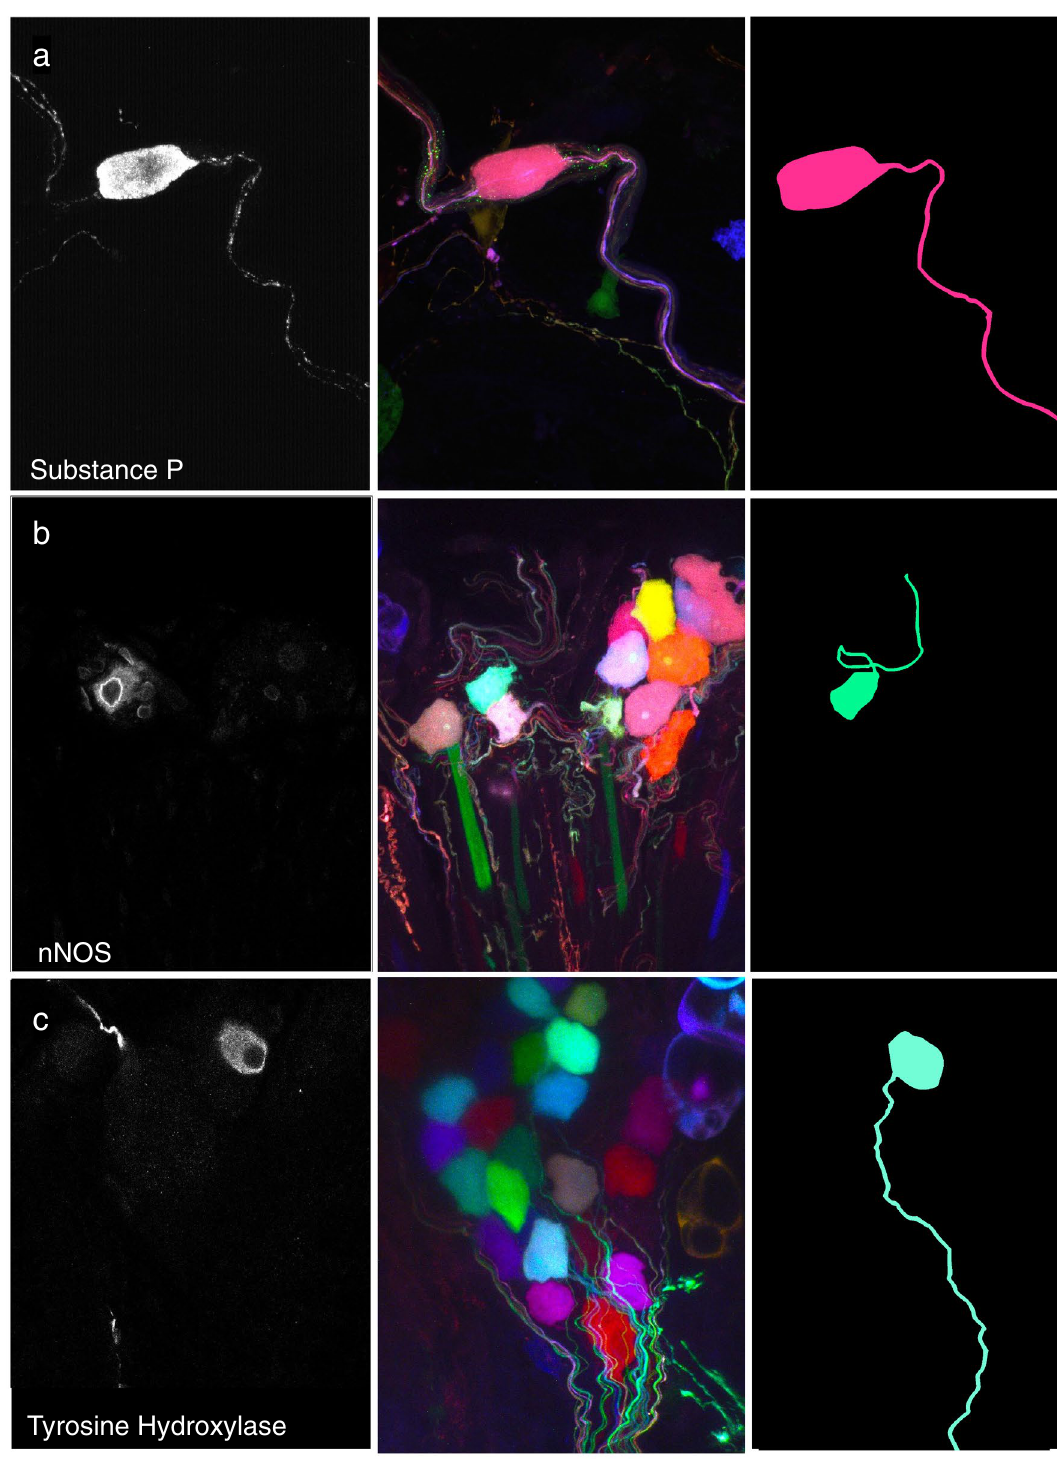
Figure 7. Tracheas immunolabeled for substance P ( a ), neuronal nitric oxide synthase ( b ), and tyrosine hydroxylase ( c ). Left column shows immunolabeling in a single plane. Middle column shows multicolor labeling of neurons in a maximum intensity projection. Right column shows traces of cell bodies and axons of labeled neurons. Two axons of very similar color are present in the substance P image, however only one originates from the cell body that is shown, as can be seen more clearly in a 3D/orthogonal view (see supplementary Fig.